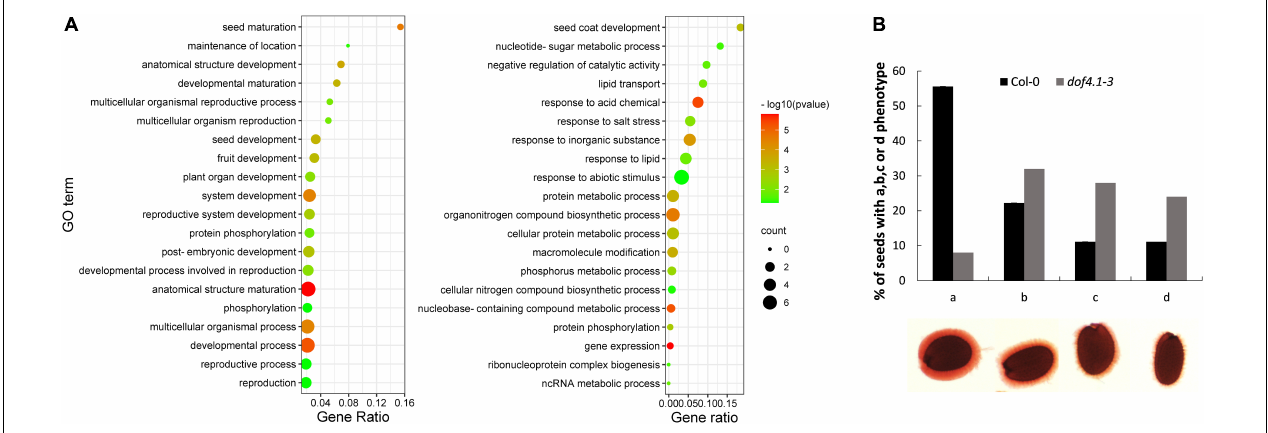
FIGURE 2 | Seed development is affected in dof4.1-3 . (A) Top-20 non-redundant enriched gene-ontology (GO) categories in dof4.1-3 upregulated (left panel) and downregulated (right panel) genes. Biological Process enrichments were obtained using Panther and filtered using REVIGO to remove semantically redundant terms. Terms were pruned by REVIGO frequency (terms with frequency > 15% were removed) and ranked by dispensability. Gene ratio: Ratio of upregulated genes in a given category divided by total number of genes in this category. Counts: Number of upregulated genes in a given category. -log p ( p -value in log scale after false discovery rate correction). (B) Histogram showing visual scoring of mucilage phenotypes, from perfect (a) to severely affected mucilage (d), after staining with ruthenium red in Col-0 and dof4.1-3 seeds. 70 seeds were analyzed per genotype. Col-0, Columbia